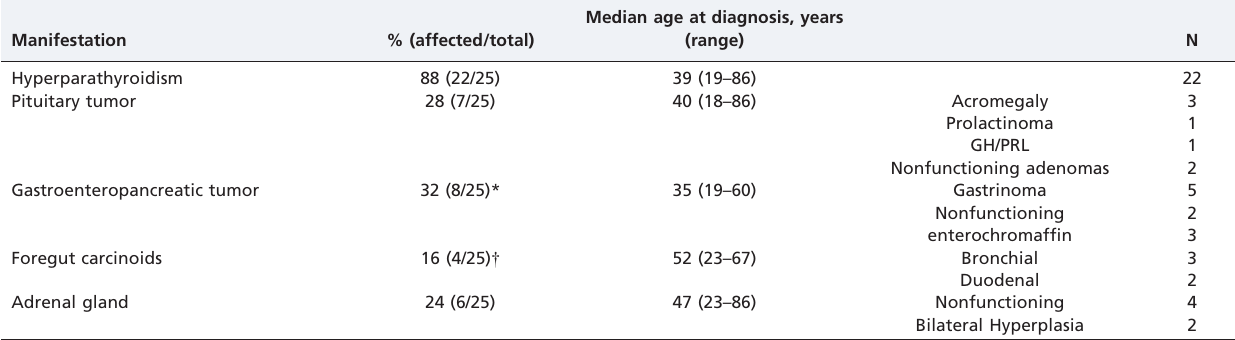
Table 3 - Prevalence of manifestations and age of diagnosis of MEN1 Chilean families. Manifestation